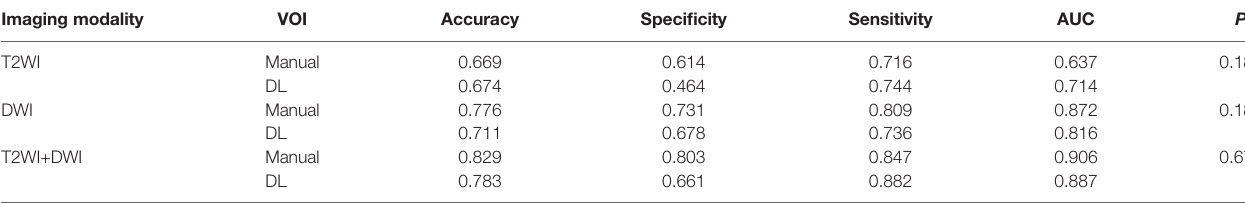
TABLE 2 | Performance of the radiomics-based models in predicting genotype (KRAS/NRAS/BRAF). Imaging modality VOI